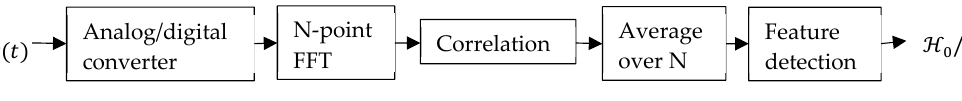
Figure 3. Block diagram of cyclostationary features based techniques [21–27].